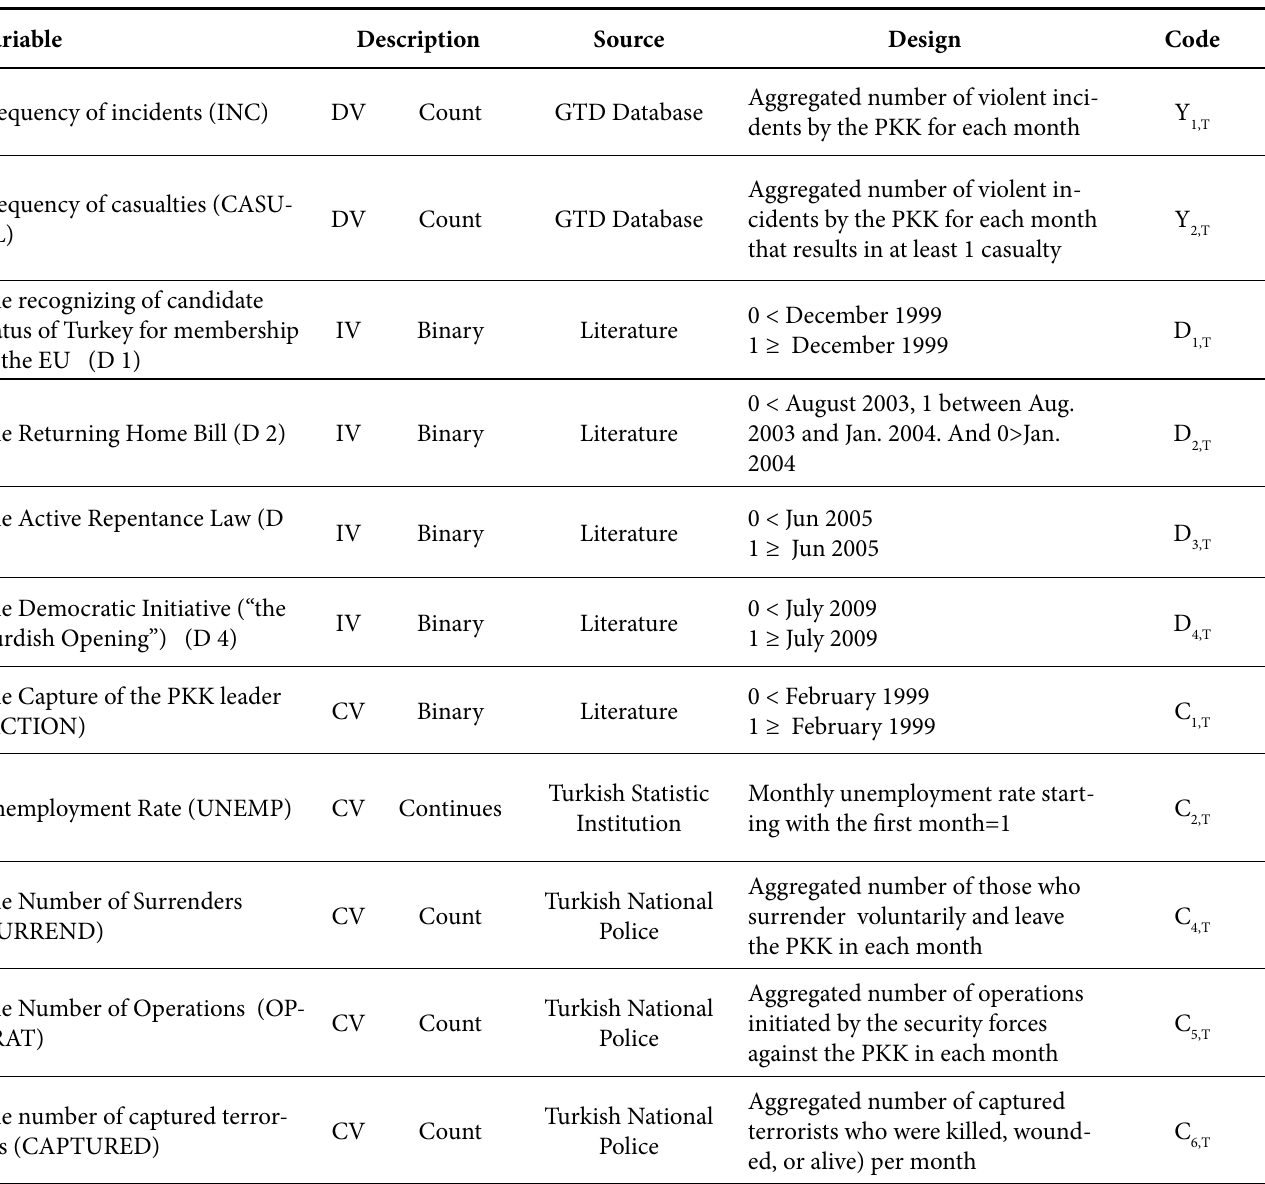
Aggregated number of violent inci- Y dents by the PKK for each month